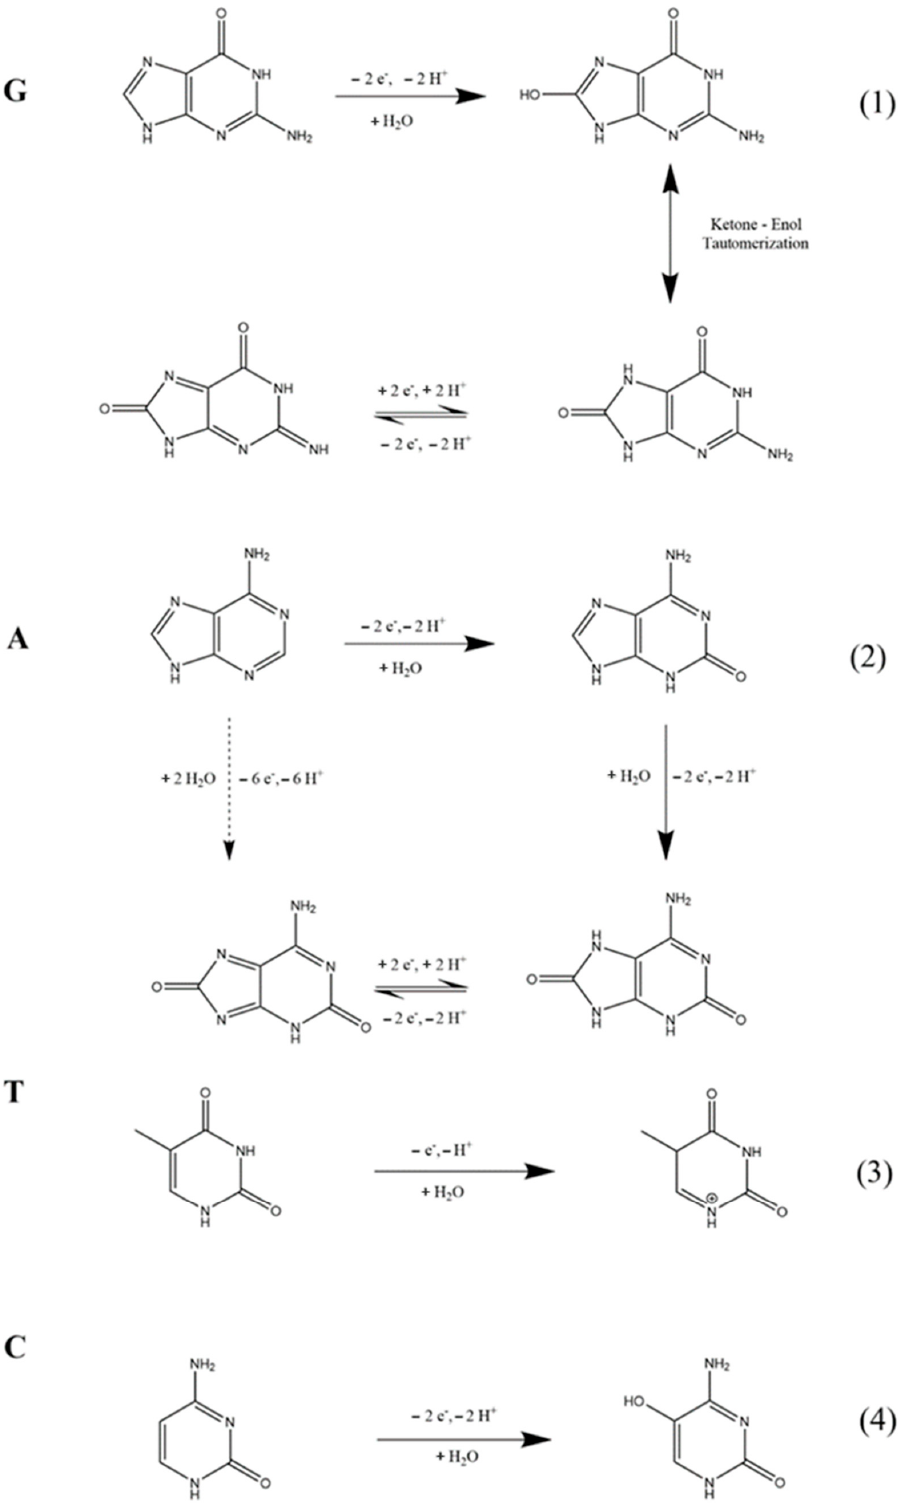
Scheme 1. The proposed oxidation mechanisms of the four DNA bases as deduced from studying the effect of pH on the anodic peak potential values.